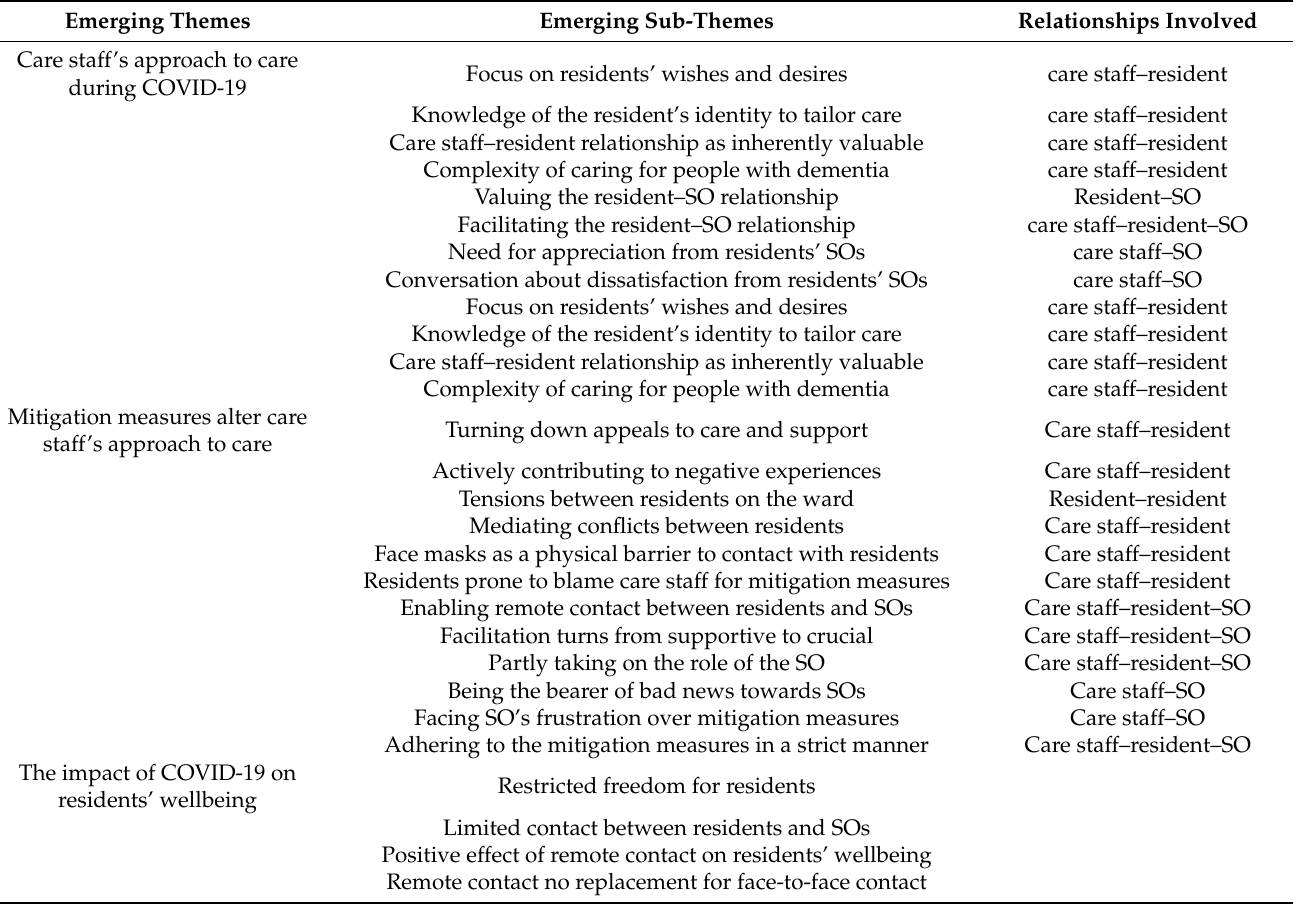
Table 1. Overview of themes emerging from care staff’s